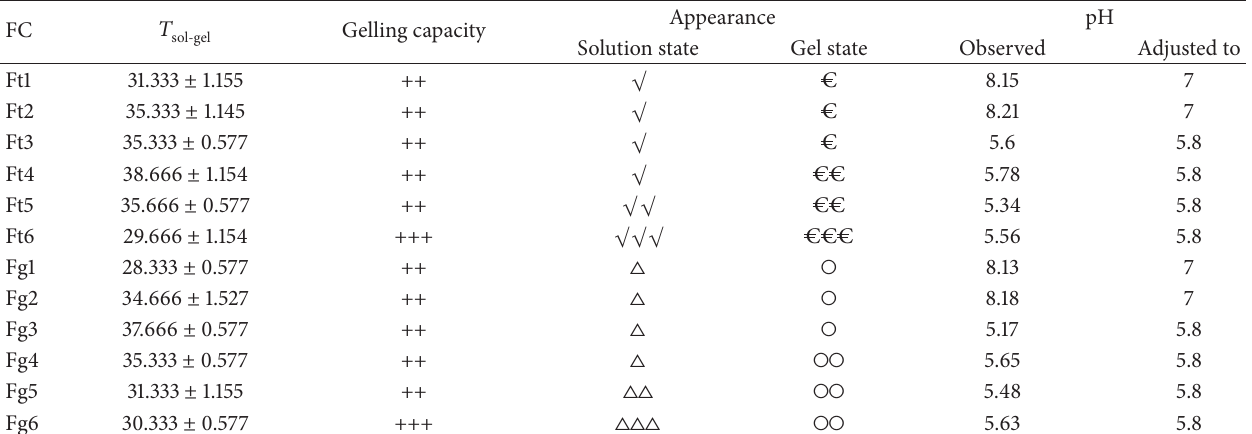
Table 4: Evaluation data 1 of in situ gel formulation.